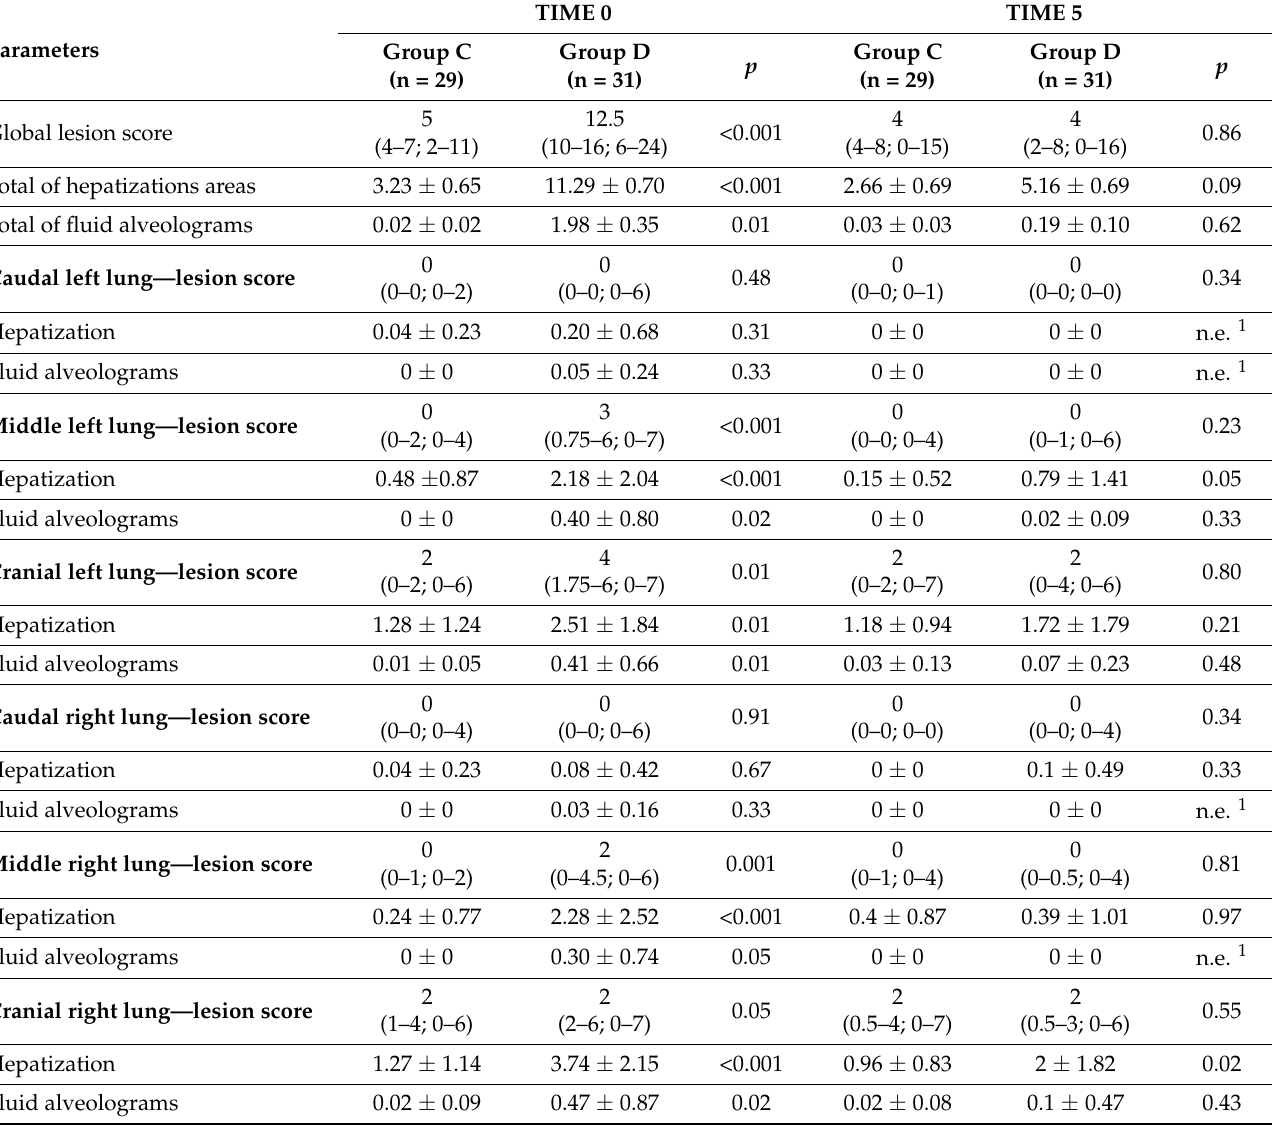
Table 2. Comparison of lung evaluations between group C and group D at T0 (Time 0; day of restocking) and T5 (Time 5; after 21 days). Data are expressed as median (1st quartile–3rd quartile; minimum value–maximum value) for not normally distributed data and as mean ± SEM for normally distributed data. Hepatization and fluid alveologram areas are expressed in cm 2 .